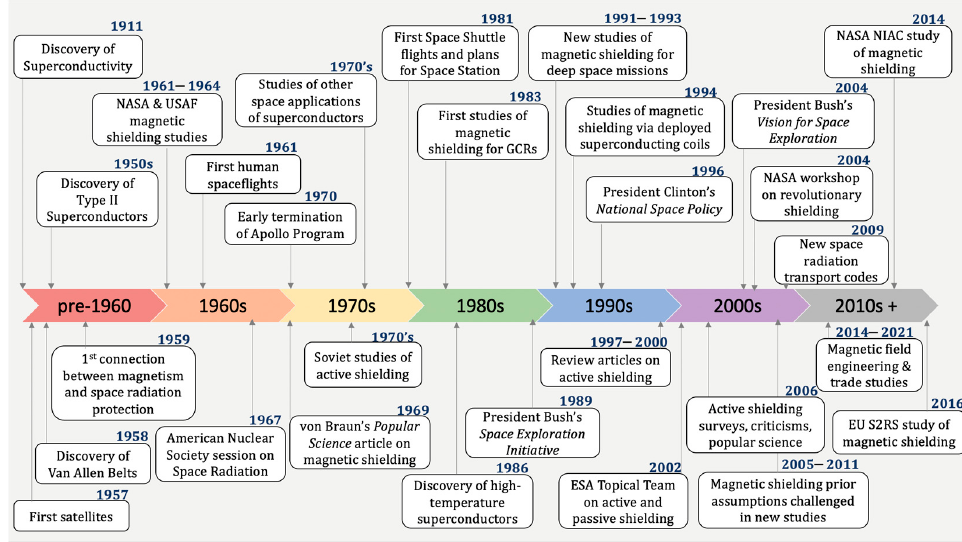
Figure 1. 50+ Years of Magnetic Shielding Studies .